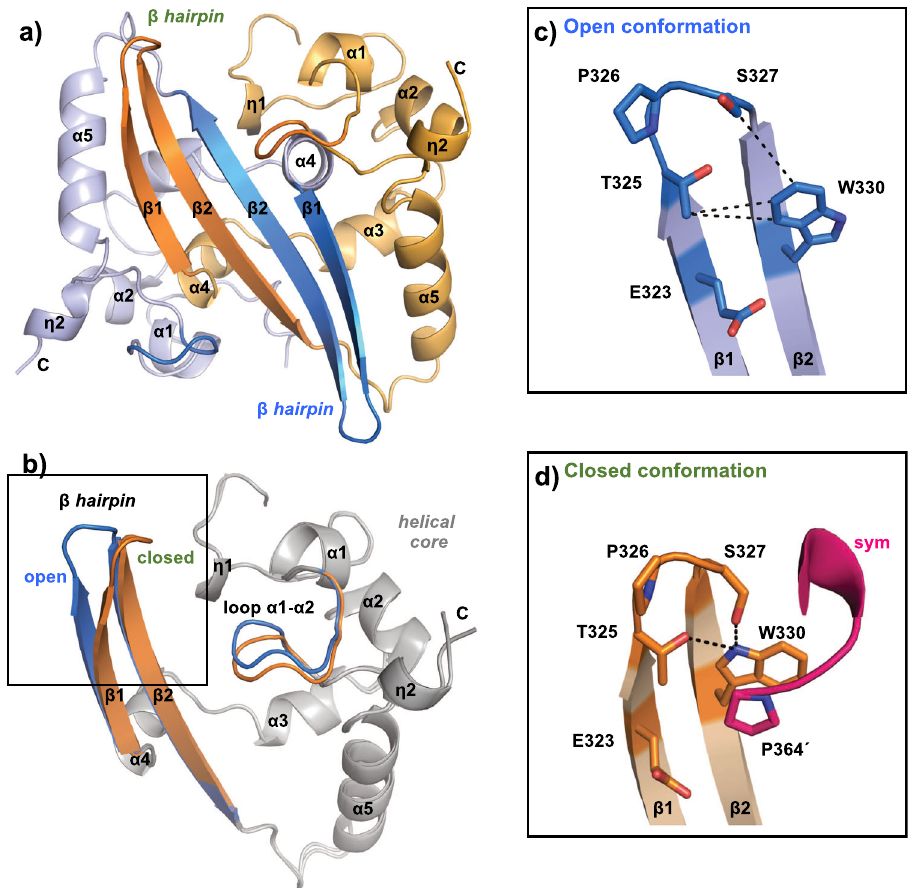
Fig. 1 Crystal structure of SARS-CoV-2 NCTD in open and closed conformations. a Cartoon representation of the N CTD dimer. Each monomer is colored in blue and orange, respectively. The β -hairpin and the loop connecting the helices α 1 – α 2 are highlighted in dark tones. Secondary structural elements and residues are numbered and labeled in order from N to C terminus: the symbol η corresponds to 3 10 helix; α to α -helix and β to β -strand. b Superimposition of the N CTD monomers. The common helical core is colored in gray. c , d Detailed view of the open ( c ) and the closed ( d ) conformations. The side chain of key residues is shown in sticks with carbon atoms colored according to the monomer to which they belong. Hydrophobic and polar interactions are represented as dashed black lines. The C-terminal of the symmetric molecule ( sym ) is colored in magenta. The symmetric Pro residue is indicated with an apostrophe. Nitrogen and oxygen atoms are colored in blue and red,